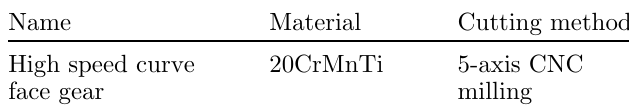
Table 3. Properties of high speed curve face